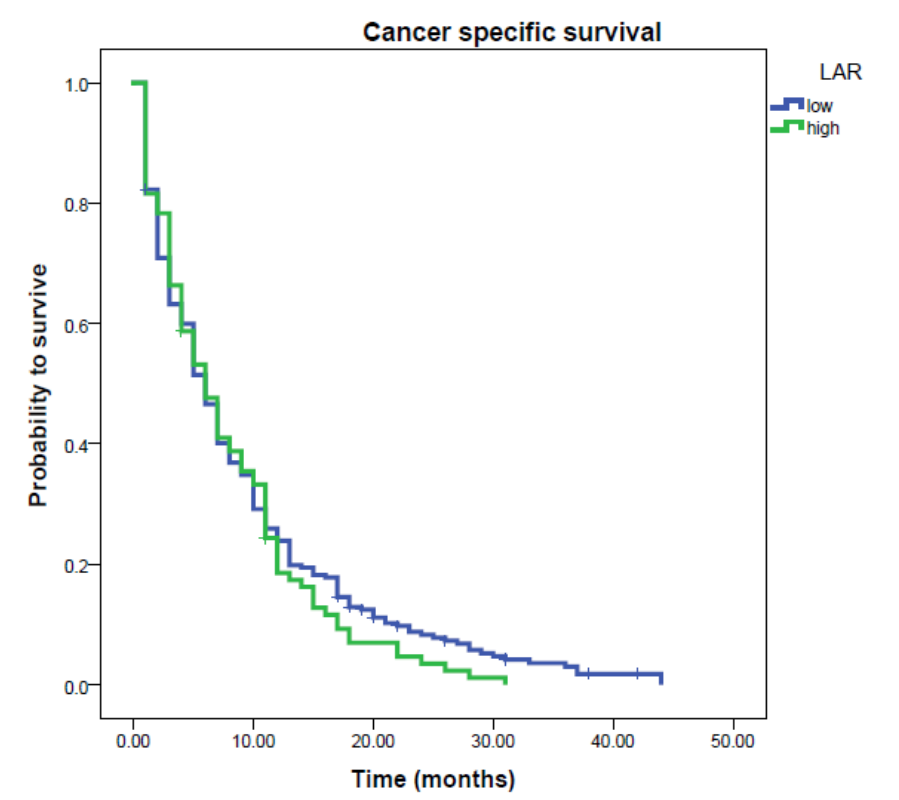
Figure 2. Kaplan–Meier curves predicting cancer-specific survival (CSS) regarding a pre-diagnostic LAR < 1.33 vs. LAR ≥ 1.33 in the study cohort comprising 351 metastatic non-surgical resectable PDAC patients ( p = 0.335).